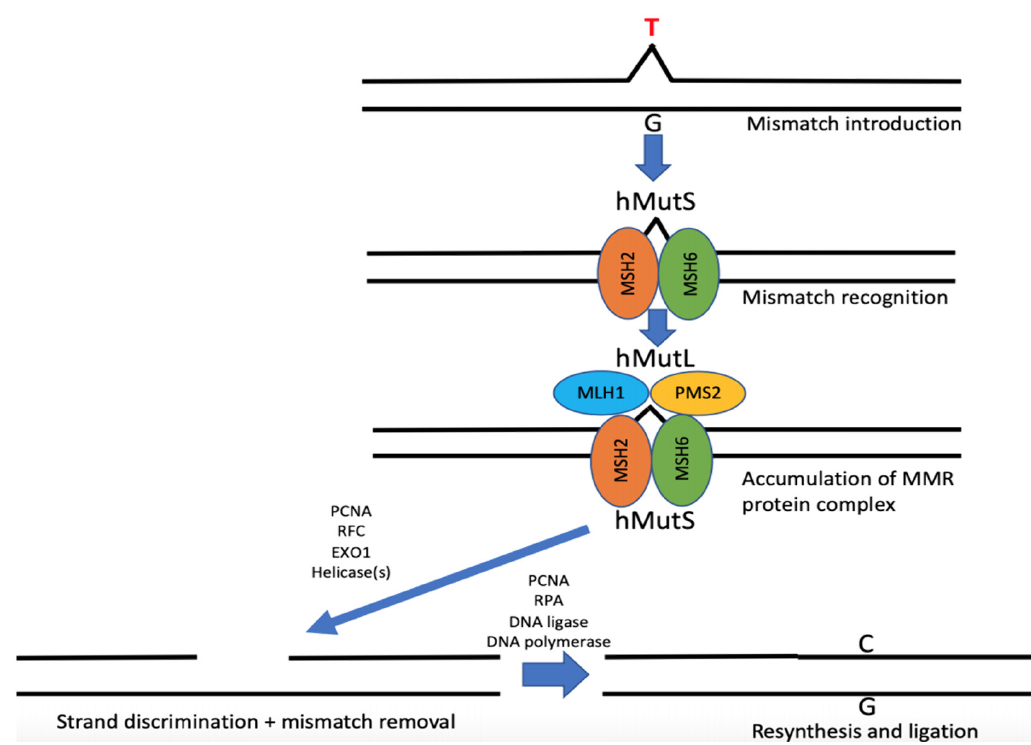
Figure 2. Sequence of protein synthesis. Four DNA mismatch repair genes are responsible for Lynch syndrome-related cancer development. MSH2 could bind mismatched nucleotides together with MSH6 . MLH1 complexes with PMS2, thus forming the MutL α complex, which is responsible for excision of the mismatched locus. Defects in these proteins may increase the percentage of mutations and diminish effectiveness of tumor suppressors. Adapted from Peltomäk et al. [21].